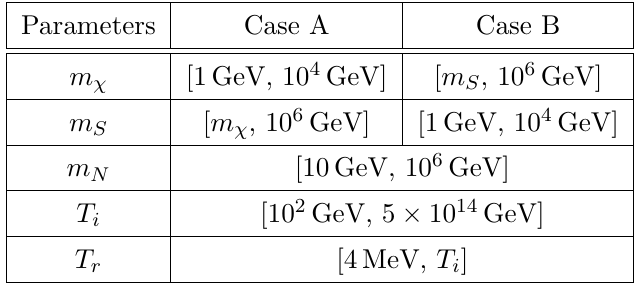
Table 1 . The scan ranges for each input parameter in all cases. Note that Y ij by m N and R = I , and (cid:21) (cid:31) is chosen to give the observed dark matter relic density and is required to be less than 4 (cid:25)